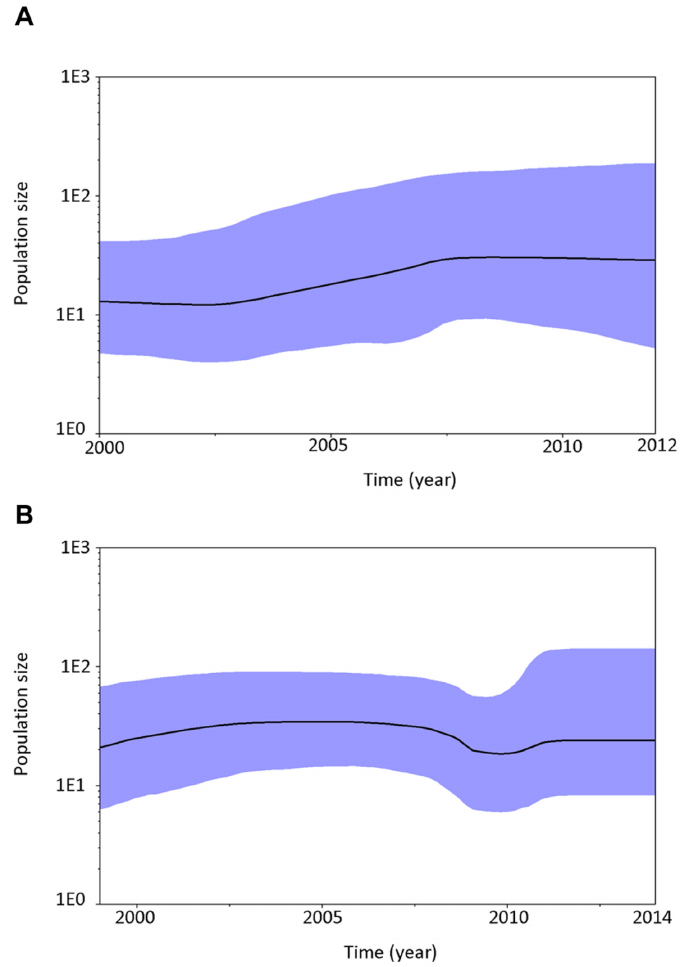
Fig 3. Effective population dynamics of DHAV-1 and DHAV-3 viruses. (A) Population dynamics of DHAV-1 viruses from 2000 to 2012. (B) Population dynamics of DHAV-3 viruses from 1999 to 2014. The estimated mean population size is shown using black line. At each time point, the blue colored region represents 95% high confidence intervals of population size. Because the generation time virus is unclear, the population size here is the product of effective population size and virus generation time. We assumed virus generation time is constant during evolution for our inference.